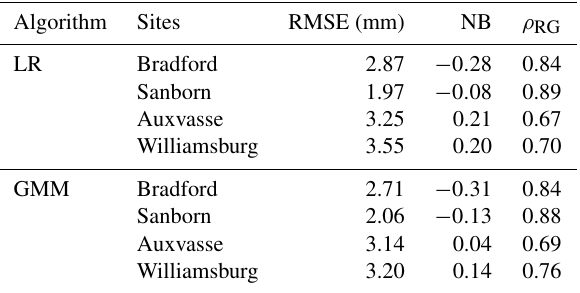
Table 2. Statistics for the comparison between the radar and gauge. RMSE: root-mean-square error; NB: normalized bias; ρ RG : Pear- son correlation coefficient; LR: linear regression model; GMM: Gaussian mixture